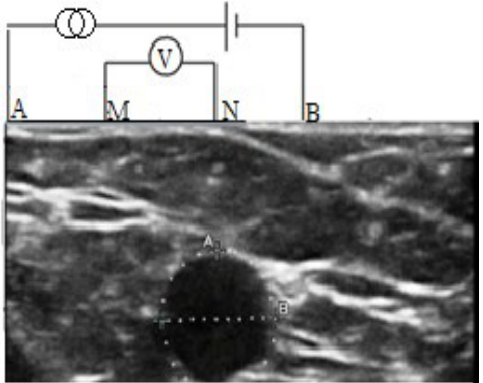
Fig. 1: Schematic drawing of the electrodes on the region of interest: A, B are the current electrodes. M, N are the potential electrodes.